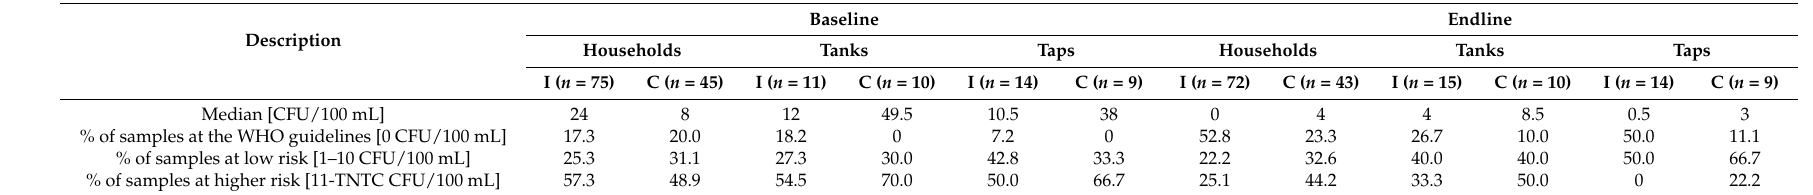
Table A2. Baseline and endline water quality at the intervention and control schemes for the households, reservoir tanks, and taps: percentages at guidelines, low risk, and high